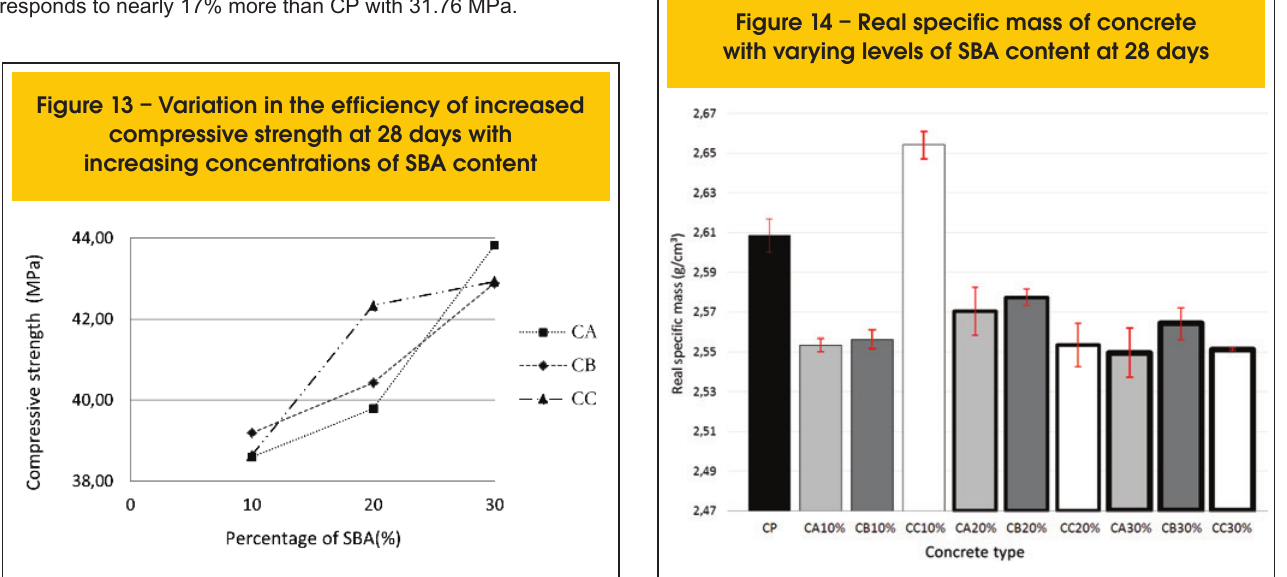
Figure 14 – Real specific mass of concrete with varying levels of SBA content at 28